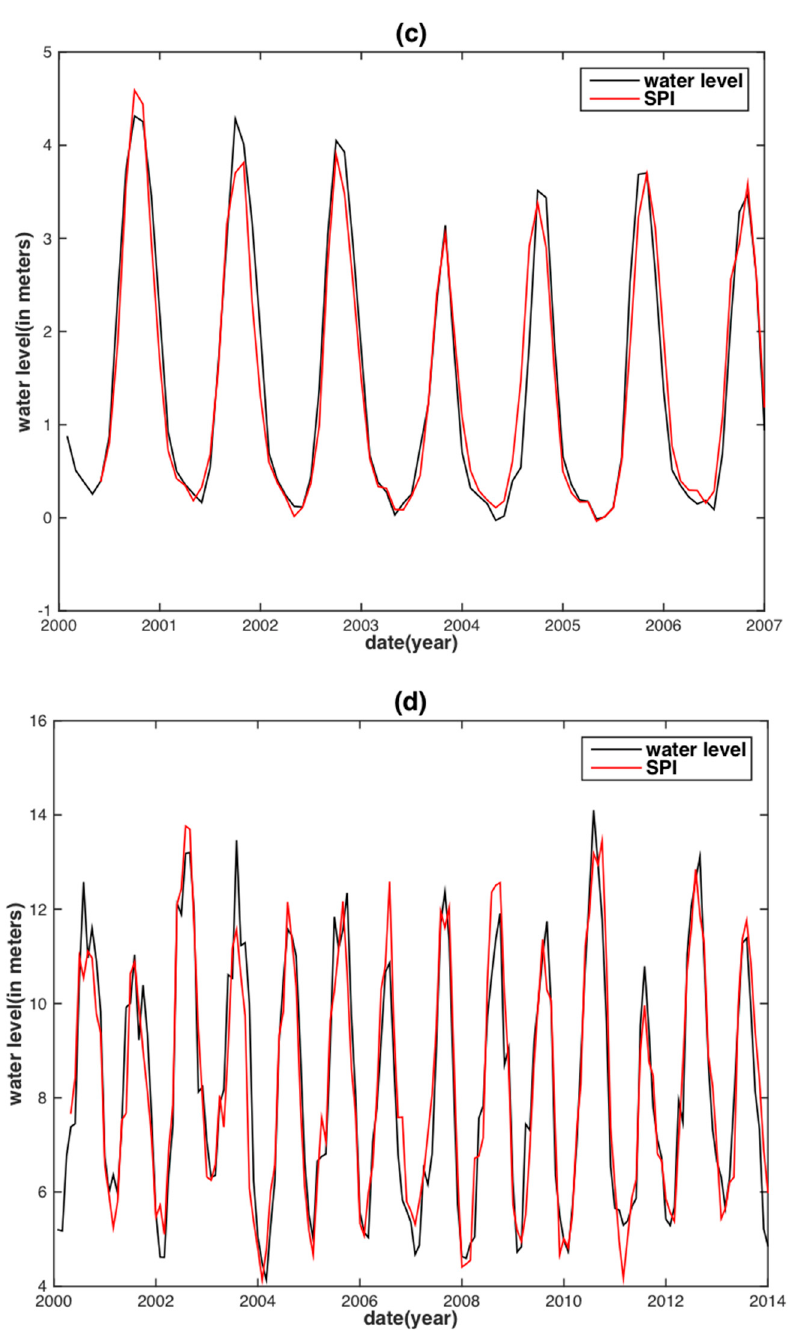
Figure 6. Time series of TRMM-SPI values against the standardized water level in the MRB ( a ) and the YRB ( b ); TRMM-SPI reconstructed water level against the observed water level in the MRB ( c ) and the YRB ( d ).